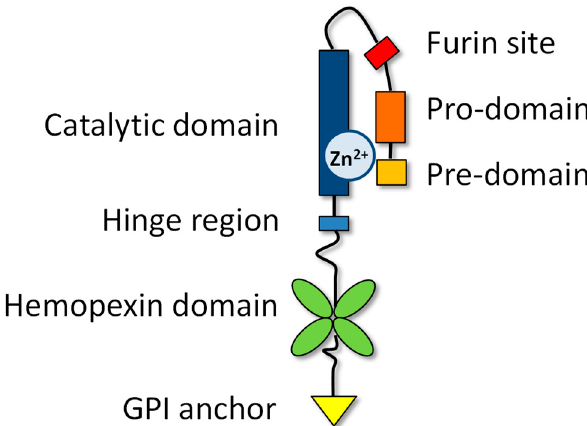
Figure 2. Structural domains of MT4-MMP, including the pre-domain or signal peptide (amino acids 1 to 41), the pro-domain (42–128), the catalytic domain with a zinc ion (129–297), a linker (298–333) containing the furin site (R–X–K / R–R), the hemopexin domain (334–535), and the glycosylphosphatidylinositol (GPI) anchored to the membrane (572-605).